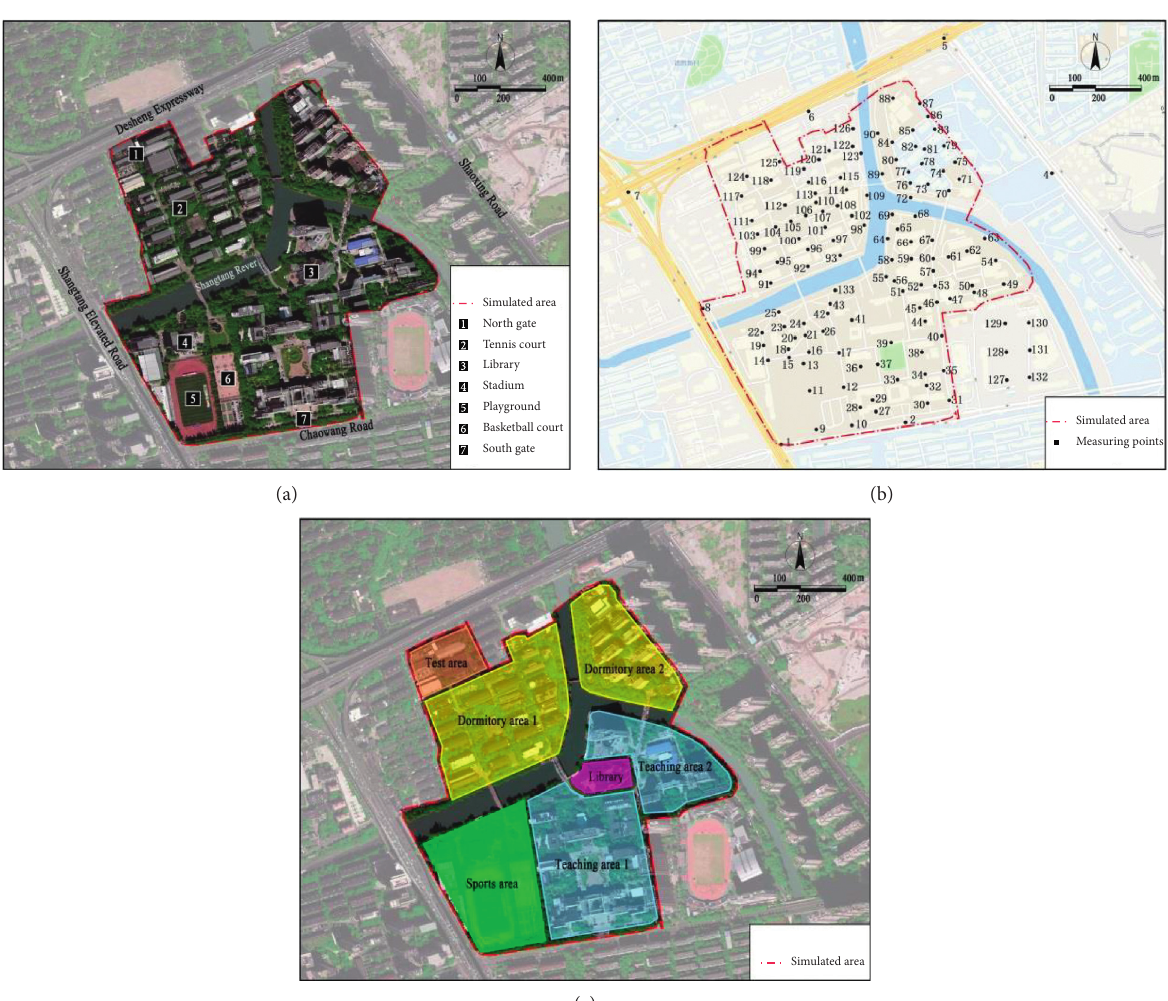
Figure 1: Zhaohui Campus of Zhejiang University of Technology: (a) campus map, (b) control map of acoustic environment measuring points, and (c) map of functional